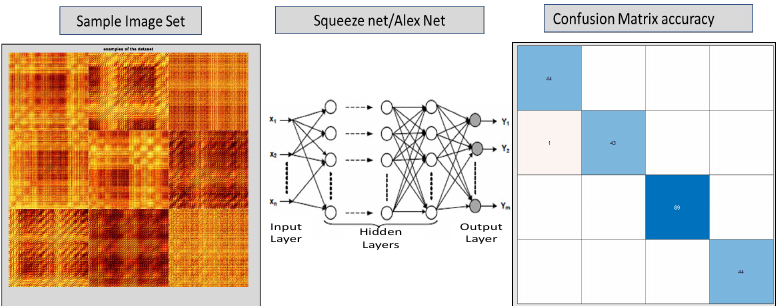
Figure 13. Figure showing conceptual workflow of how Alextnet or Squeezenet will be used for image classification using Color recurrence plots.